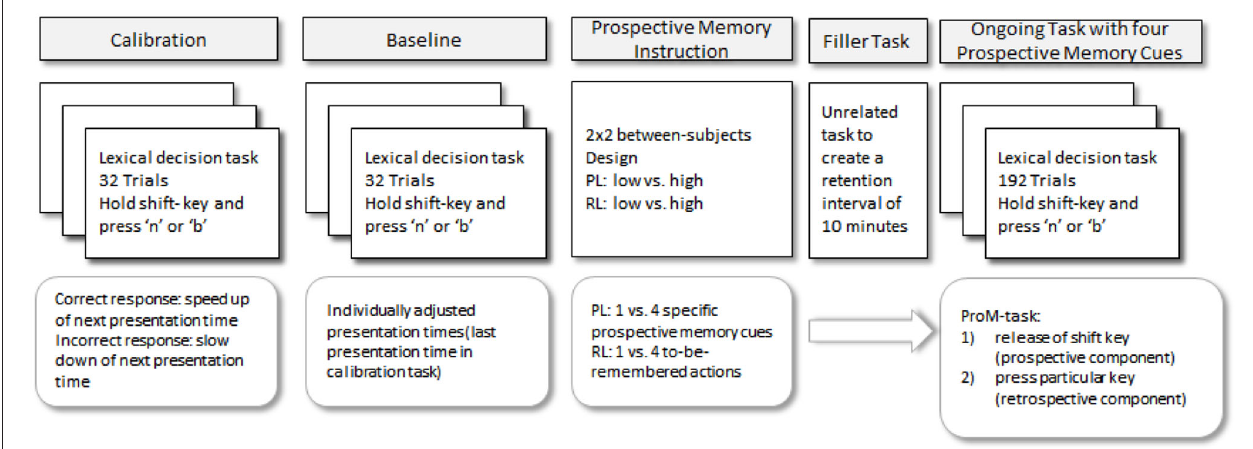
FIGURE 1 | Schematic depiction of the procedure for Experiment 1 .